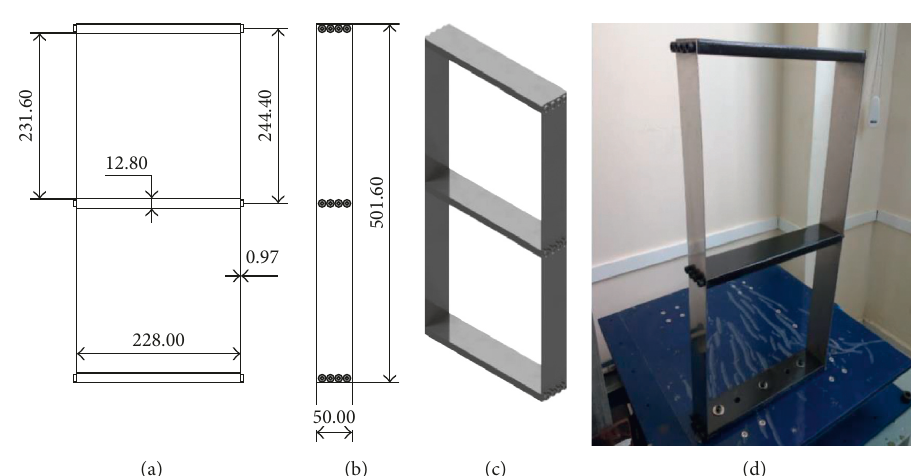
Figure 4: Technical drawing of the prototype. (a) Front view, (b) lateral view, (c) exploded view of the structure, and (d) real model on the shake